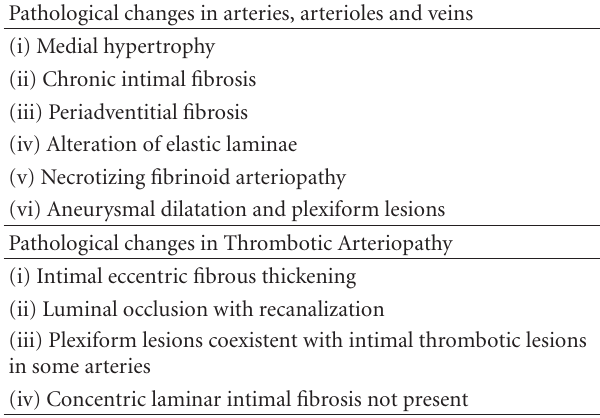
Table 2: Pathology of systemic lupus erythematosus associated pulmonary